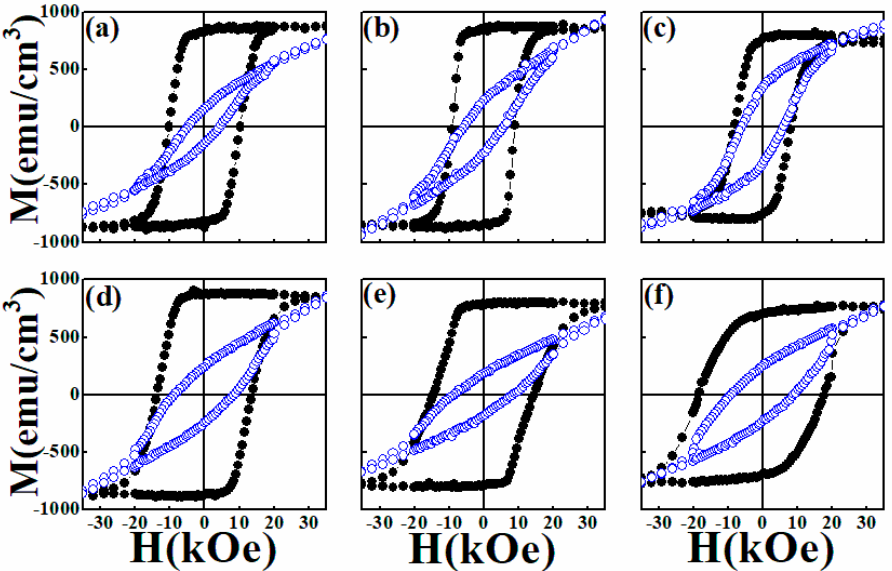
Figure 4. The out-of-plane (- • -) and in-plane (- o -) and in-plane field-dependent magnetic hysteresis loops of ( a ) reference sample FePt (14 nm), and sample series (II) FePt (6 nm)(Ag, C)(x vol %) / [MgTiTaON (1 nm) / FePt(4 nm)(Ag, C)(x vol %)] 2 ; ( b ) x = 0; ( c ) x = 10; ( d ) x = 20; ( e ) x = 30; ( f ) x = 40.